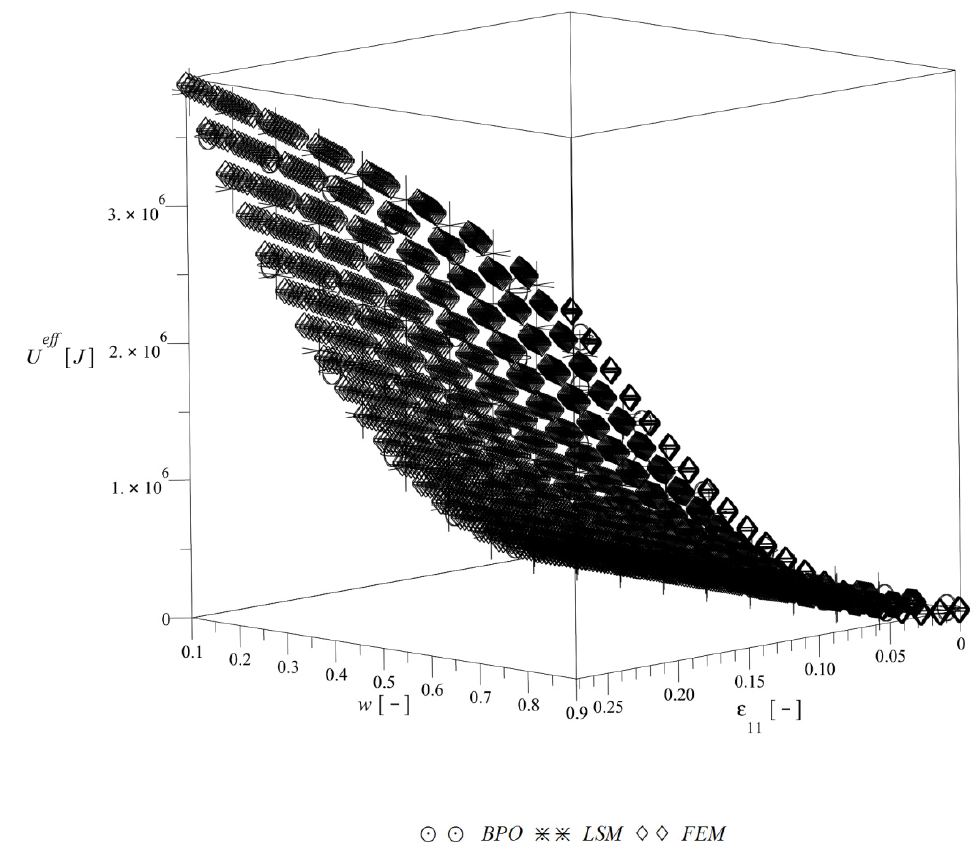
ff ective deformation energy of the composite. Figure 6. Effective deformation energy of the composite. Figure 6. E